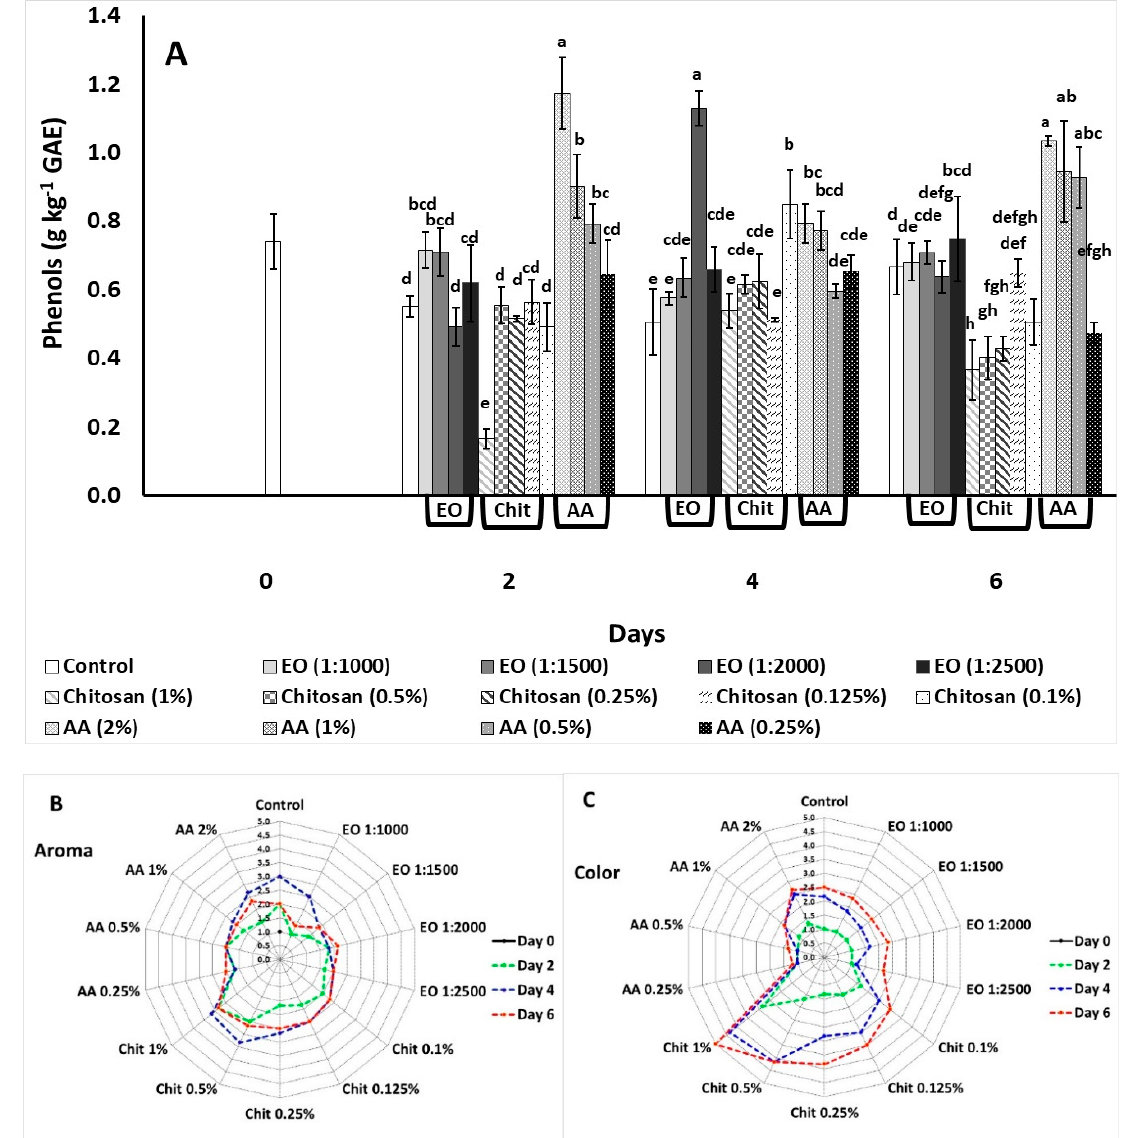
Figure 1. Screening of marjoram essential oil (EO), chitosan (Chit), and ascorbic acid (AA) on fresh-cut lettuce ( A ) total phenols (g kg − 1 GAE), ( B ) aroma (scale range from 1—lettuce like to 5—not lettuce, not acceptable), and ( C ) color/visual quality (scale: 1—green; 3—light discoloration; 5—severe browning) after 6 days of storage at 7 °C and 90% RH. On the columns, significant differences ( p < 0.05) among treatments are indicated by different Latin letters for different days. Values of phenolics represent means (±SE) of measurements on three biological replicates per treatment. Aroma and color evaluation were assessed by 7 untrained panelists. GAE, gallic acid equivalents.